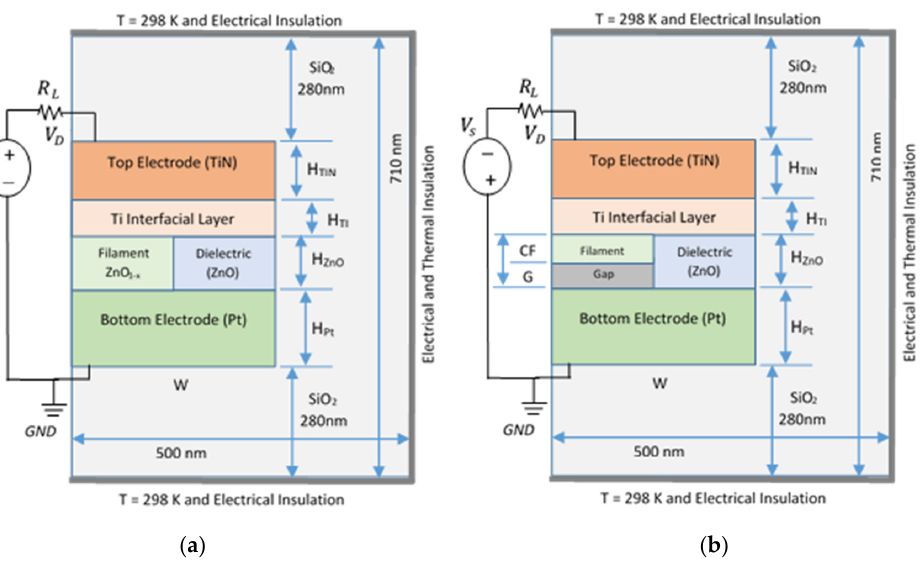
Figure 3. The TiN/Ti/ZnO/Pt device schematic (figures are not sketched to their true scales). ( a ) A diagram of the SET and ON device models. ( b ) A diagram of the OFF and RESET device models. In addition, the sketches depict various boundary conditions, material layers, and symmetrical parameters. Table 1. Material parameters used in the model [25–34].